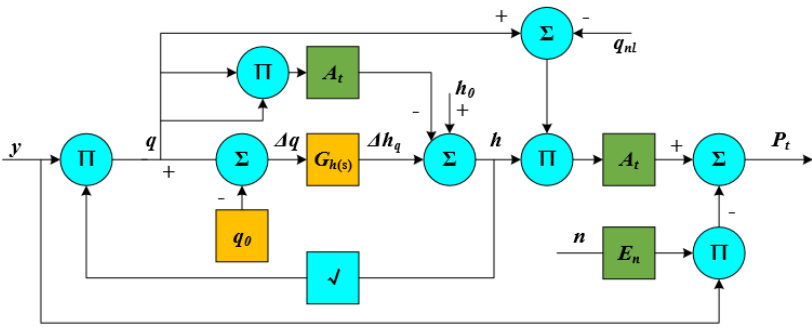
Figure 1. Block diagram of HTGS.